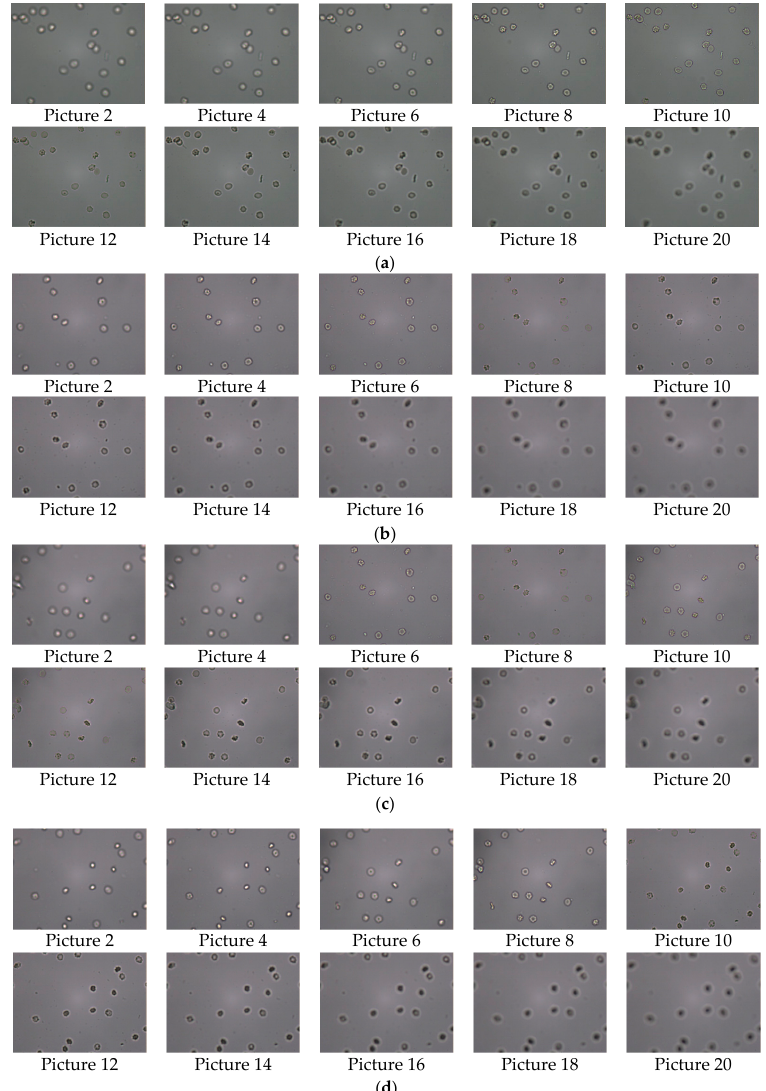
Figure 4. Four groups of test experiment diagrams: ( a ) Group 1; ( b ) Group 3; ( c ) Group 4; ( d ) Group 9.